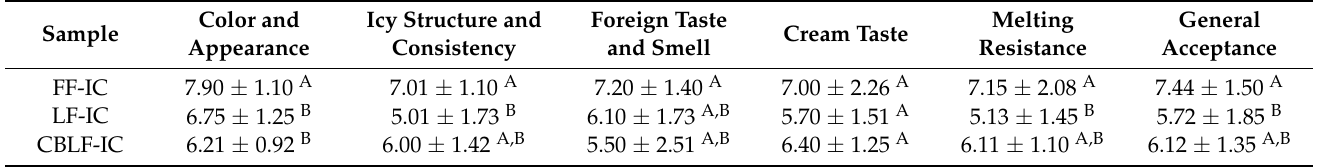
Table 5. Sensory analysis of ice cream samples.